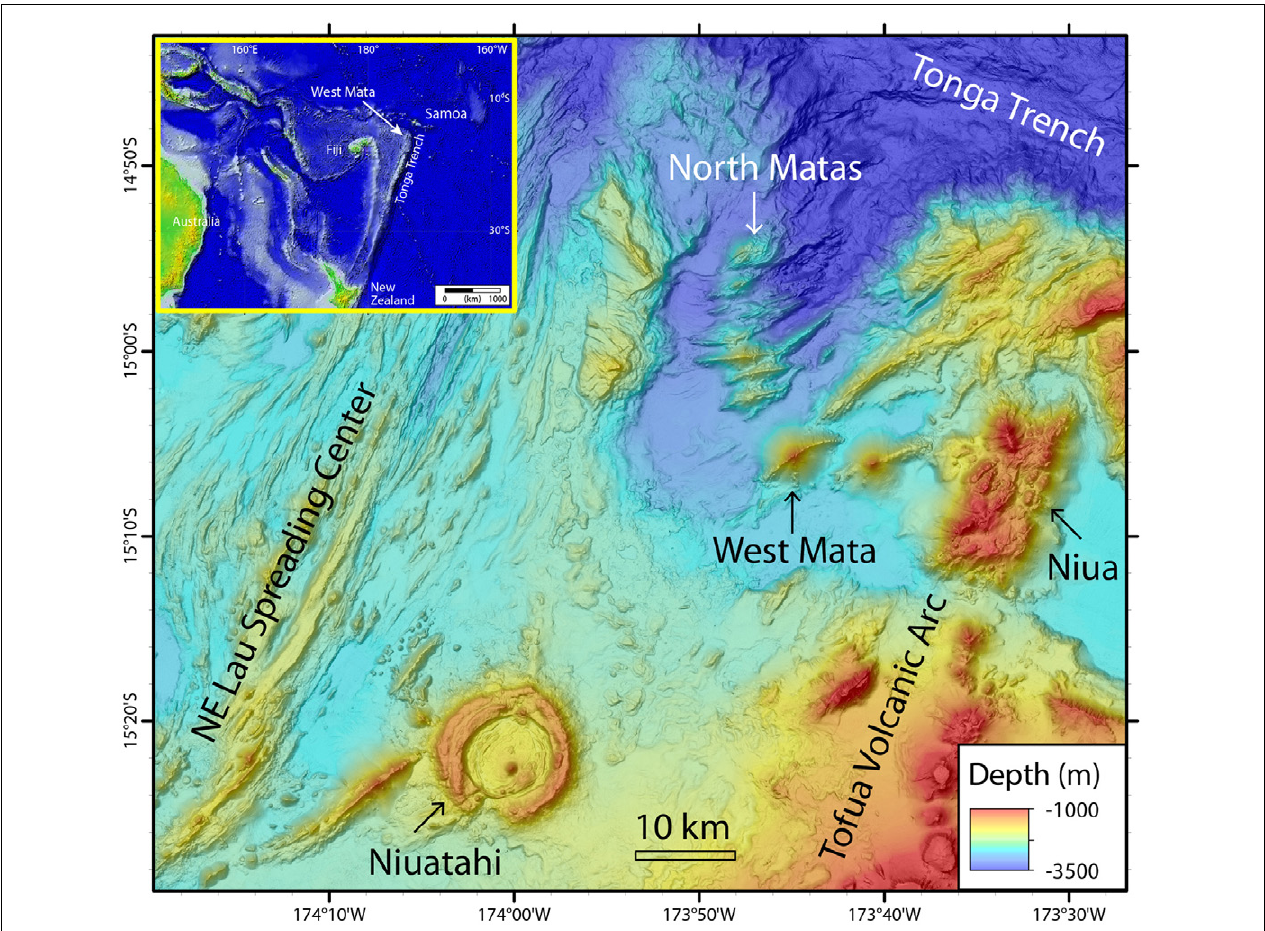
FIGURE 1 | Regional map of the NE Lau Basin, located between Fiji and Samoa (inset), showing West Mata submarine volcano, between the NE Lau back-arc Spreading Center to the west and the Tofua volcanic arc to the